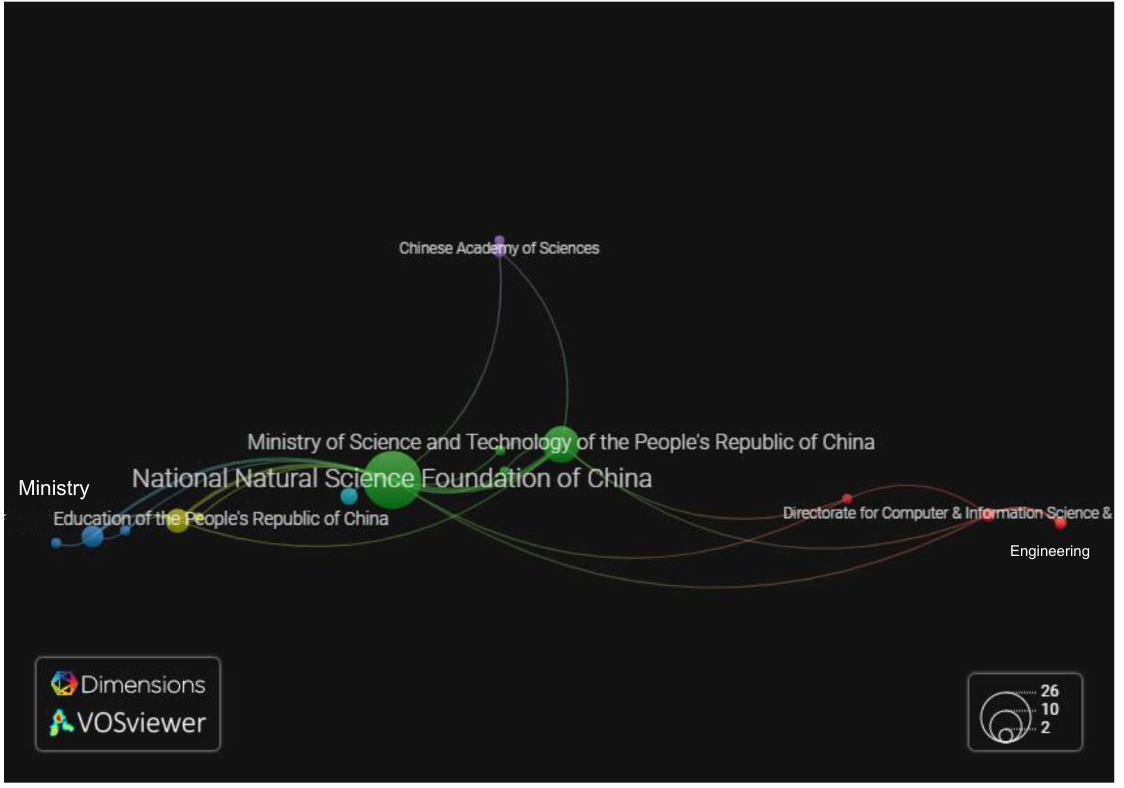
Figure 9. Funders distribution by